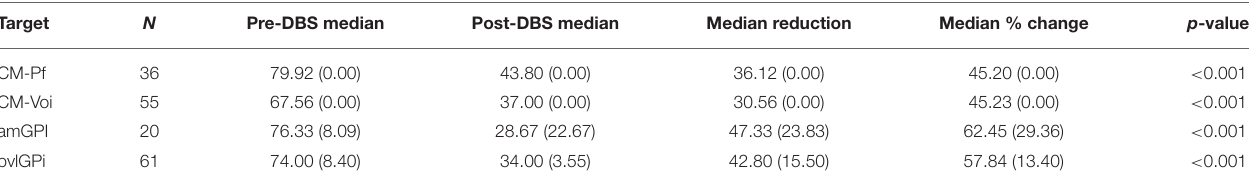
TABLE 2 | Overview of global YGTSS outcomes for the different targets at T2 (6–12 months post-operatively).